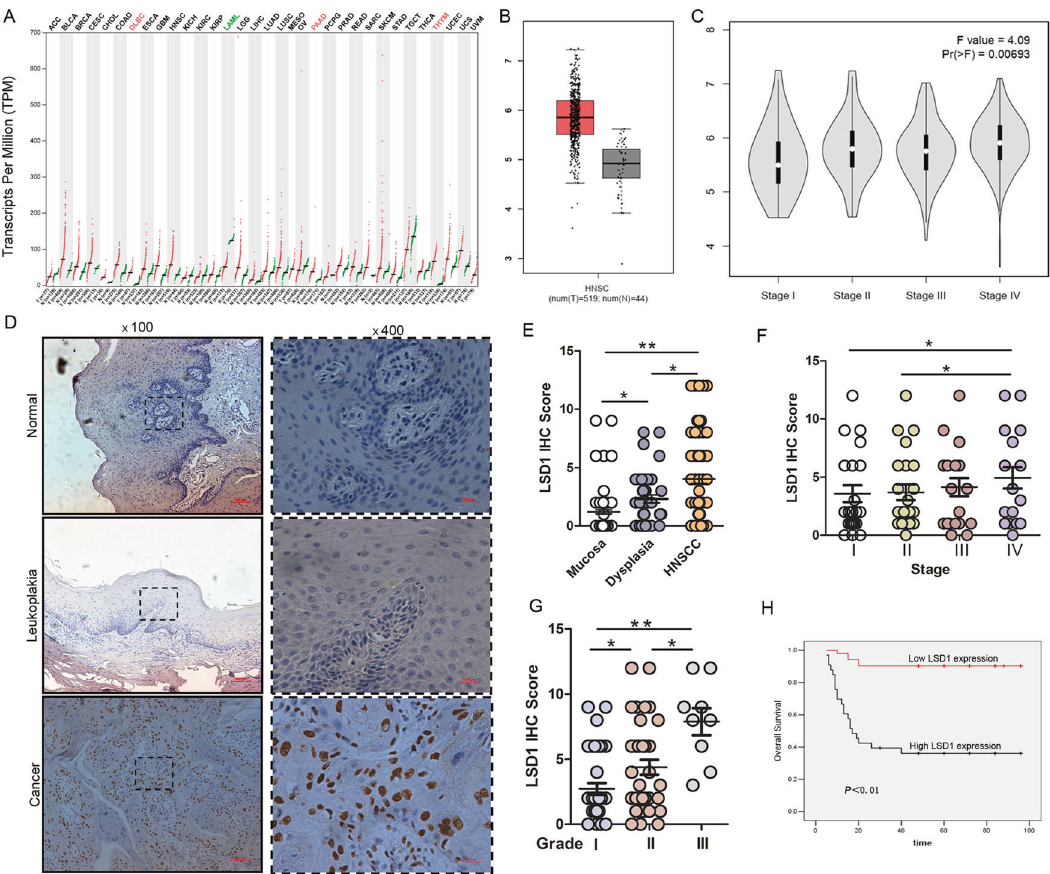
Fig. 1 High LSD1 expression predicts a poor prognosis in HNSCC patients. A The expression levels of LSD1 were detected in different types of cancers from the GEPIA public database. B The GEPIA database revealed that LSD1 expression was signi fi cantly upregulated in HNSCC patients. C Correlation between the expression level of LSD1 and the pathological stage of HNSCC patients (GEPIA). D Representative images of LSD1 expression in normal tissues, leukoplakia tissues, and HNSCC tissues via immunohistochemical (IHC) staining. Scale bar: 100 μ m. E IHC scores for LSD1 expression in normal, leukoplakia, and HNSCC tissues. F IHC scores for LSD1 expression in HNSCC samples in different TNM stages. G IHC scores for LSD1 expression in HNSCC with different grades. H High LSD1 expression signi fi cantly correlates with poor survival in HNSCC patients. The survival rates of patients with LSD1-low and LSD1-high tumors ( P < 0.01) were determined using Kaplan – Meier survival test. (* p < 0.05, ** p <